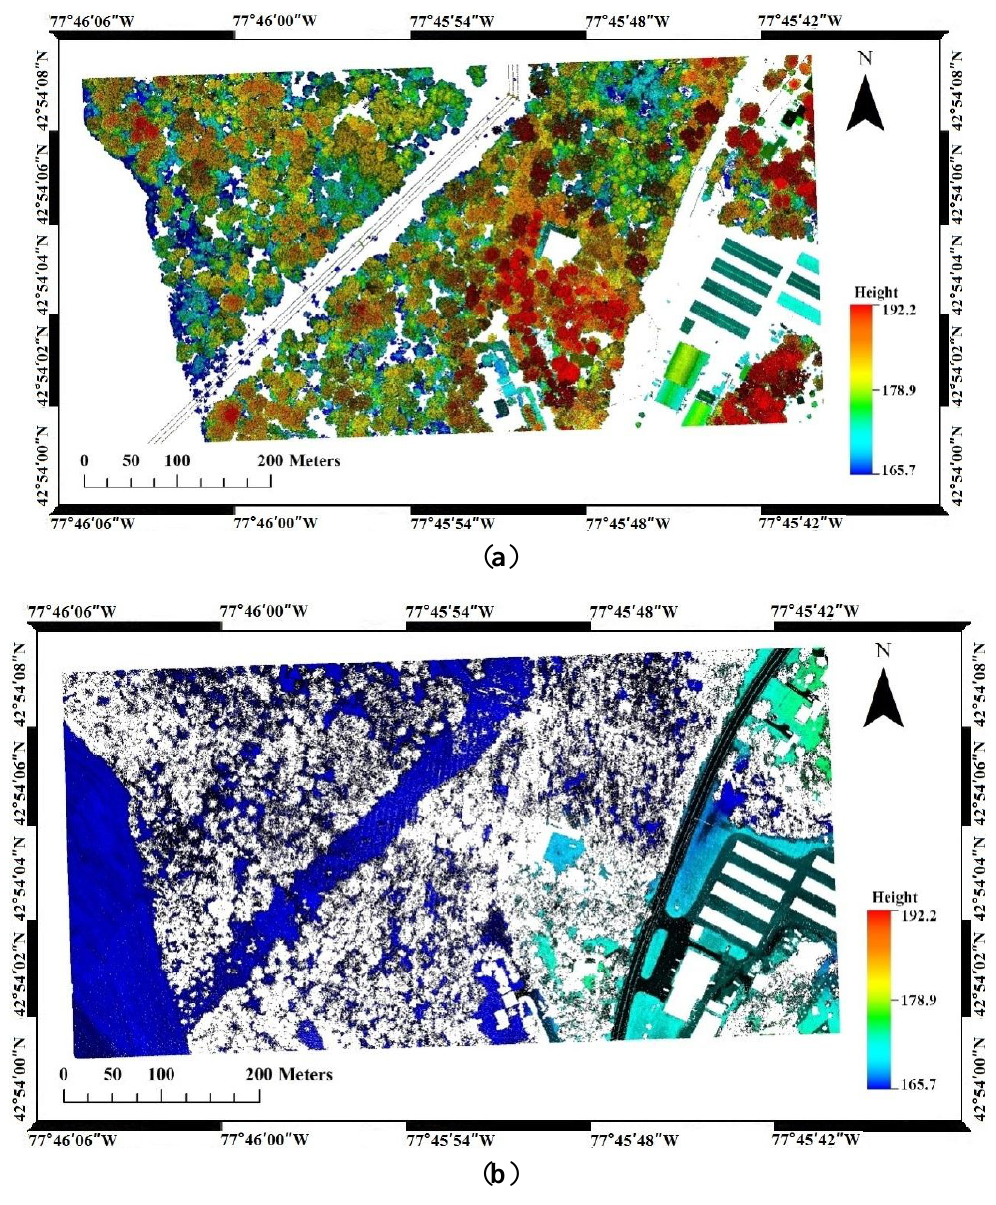
Figure 9. Non-ground points ( a ) and ground points ( b ) after